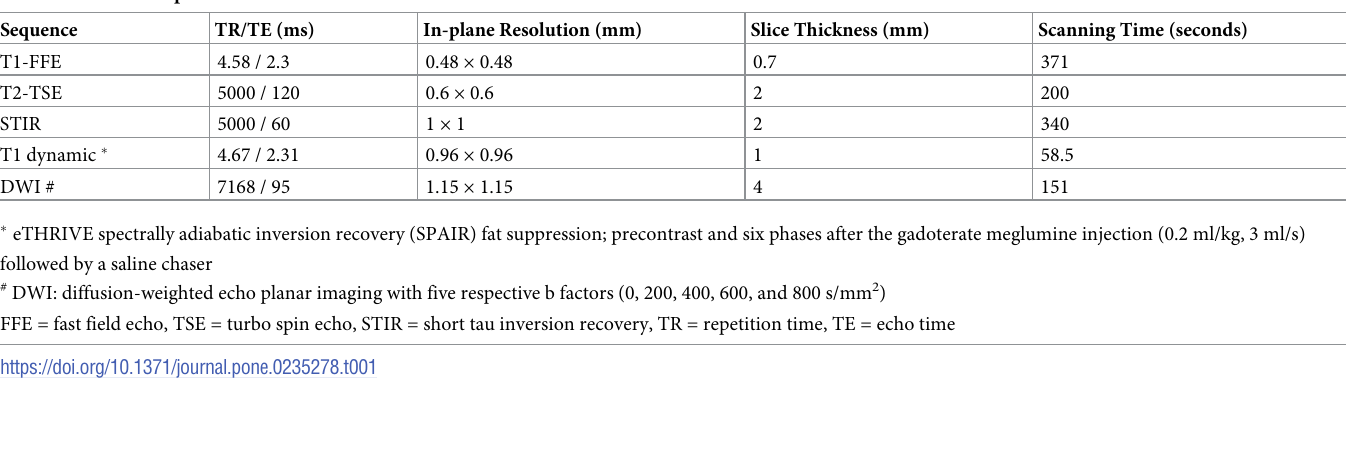
Table 1. Breast MRI